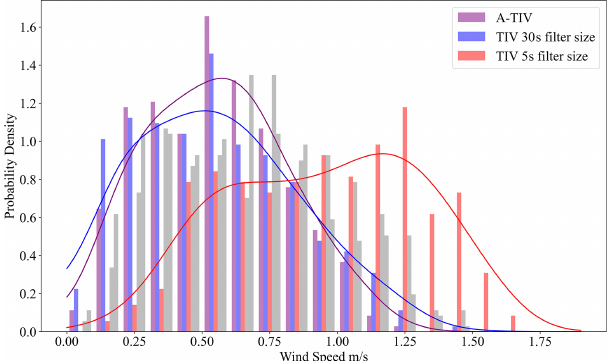
Figure 12. Impact of the lowest and highest perturbation running filter size on the wheat stubble A-TIV result – the blue histogram is based on the 30s perturbation window and the red histogram on the 5s perturbation window. The combined final wind speed histogram is shown in purple. The perturbation temporal running filter sizes of 10 and 20s are shown in grey.